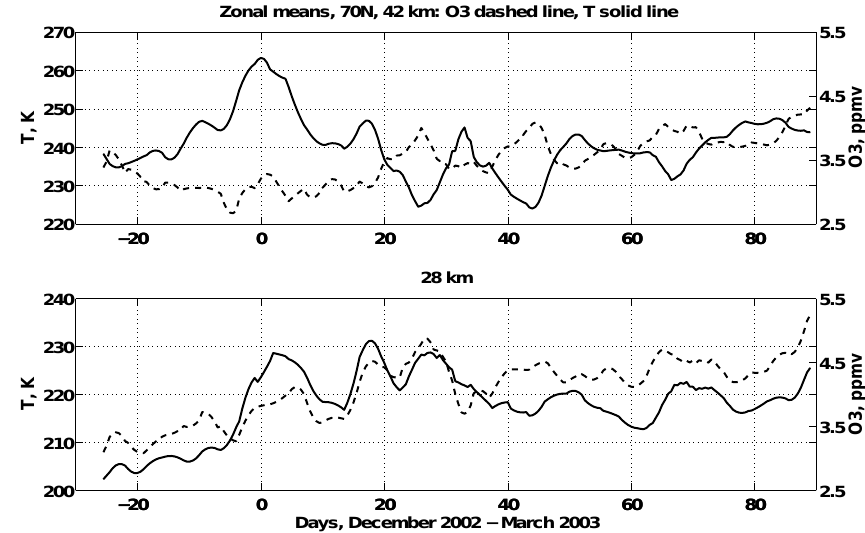
Zonal means, 70N, 42 km: O3 dashed line, T solid line